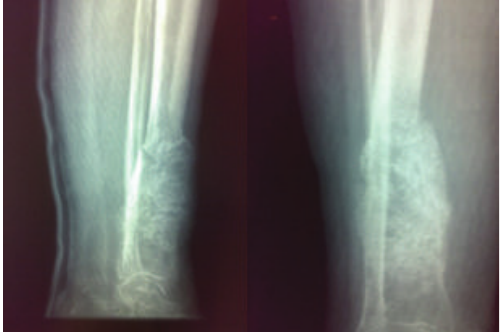
Figure 3: Radiograph of the tibial metastasis showing the increased dimensions and the soft-tissue